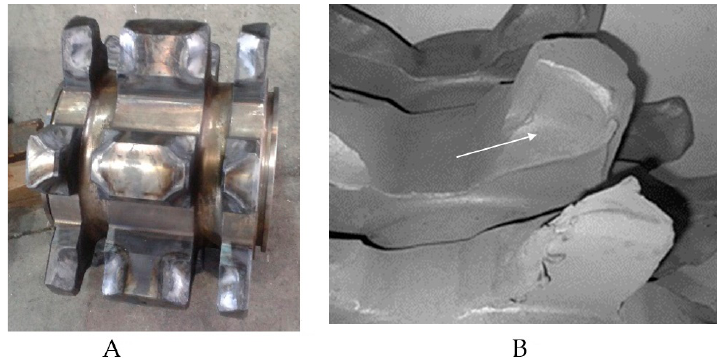
Figure 1. Chain wheel. ( A ) View of not damaged chain drum. ( B ) Damage to chain drums caused by abrasive wear by solid particles; the wear area is indicated by an arrow.